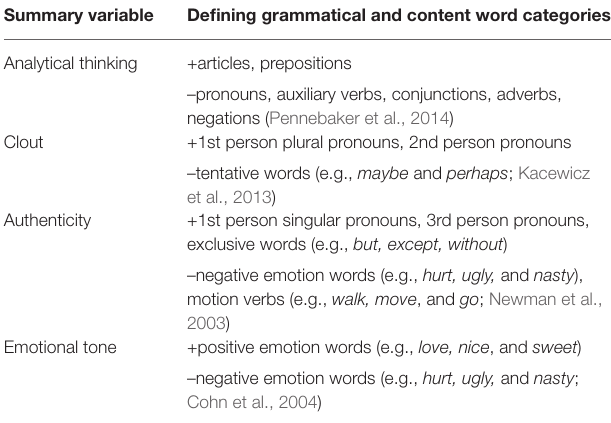
TABLE 1 | LIWC summary